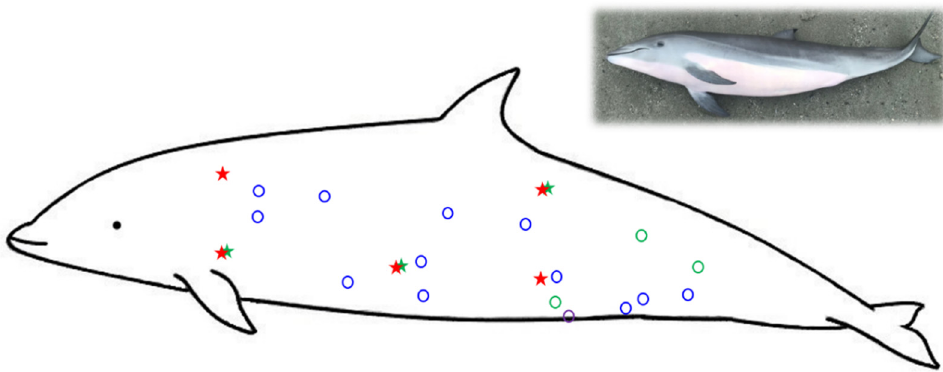
Figure 1. The sampling locations in the current study. ★ : normal skin; ○ : wounded skin. Blue marks: animal ID TP20190115; green: IL20191105; red: ML20200807; purple: PT20201109.